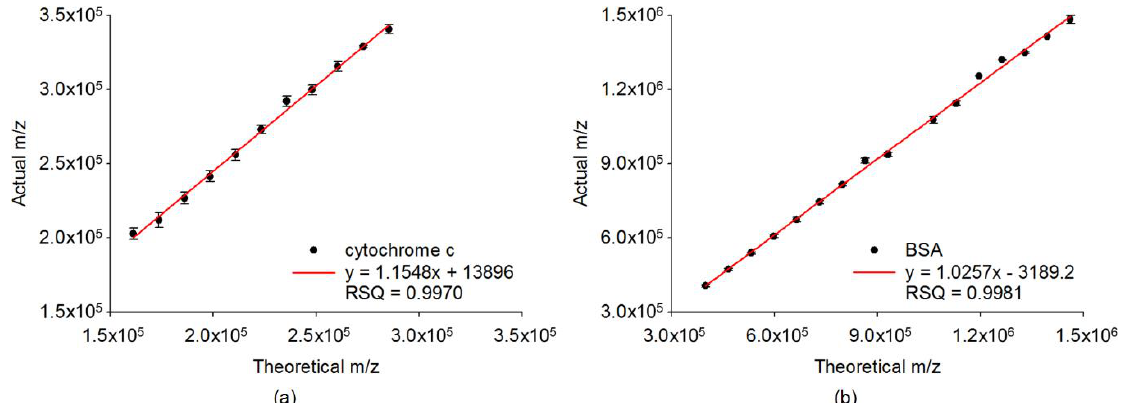
Figure 3. Mass calibration curves of expected m / z (theoretical value) versus measured m / z (actual value) for mass spectra of ( a ) cytochrome c with mass range from 150 kDa to 350 kDa, and ( b ) bovine serum albumin (BSA) with a mass range from 300 kDa to 1500